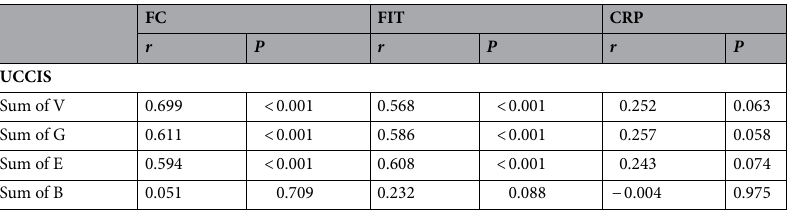
Table 5. Correlations between biomarkers and the descriptors of UCCIS in the MES 0, 1 group. UCCIS Ulcerative colitis colonoscopic index of severity, FC Fecal calprotectin, FIT Fecal immunochemical occult blood test, CRP C-reactive protein , r Correlation coefficient, V Vascular pattern, G Granularity, E Erosions and ulcers, B Bleeding, Sum of V Sum of vascular pattern, Sum of G Sum of granularity, Sum of E Sum of erosions and ulcers, Sum of B Sum of bleeding/friability.